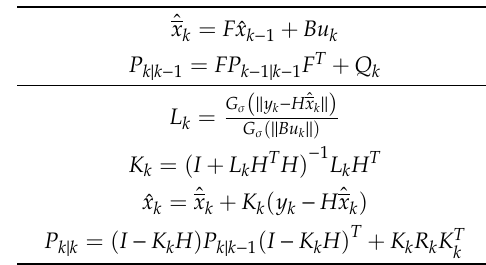
Table 4. Correntropy extended Kalman filter